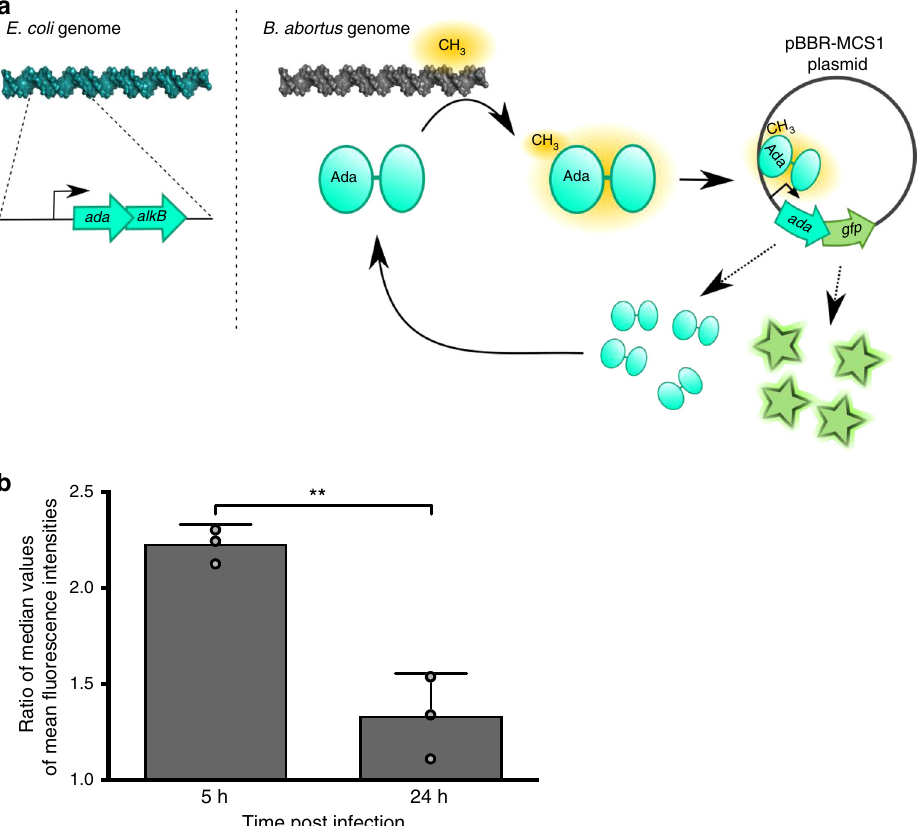
Fig. 2 Reporter system for alkylation stress. a Schematic representation of the reporter system. The sequence corresponding to ada E. coli and its promoter were cloned into a pBBR-MCS1 plasmid and a superfolder gfp was inserted downstream ada E. coli . This plasmid (pBBR-p ada - ada - gfp ) was transferred to B. abortus . When Ada E. coli detects a methylphosphotriester group on B. abortus DNA, it activates the expression of its own promoter, which leads to an accumulation of Ada E. coli and GFP. Note that a mutation in ada E. coli (C38A) leads to the abrogation of its ability to bind methylphosphotriester. b Bacteria carrying either the pBBR-p ada - ada - gfp reporter system or its mutated version ( ada C38A ) were used to infect RAW 264.7 macrophages and mean fl uorescence intensities (FITC channel) were calculated at 5 or 24 h post infection ( n = 60). Ratio of median values ( ada / ada C38A ) were plotted for biological triplicates. Error bars correspond to standard deviation. Student ’ s t -test was performed with p < 0.01 (**). Source data are provided as a